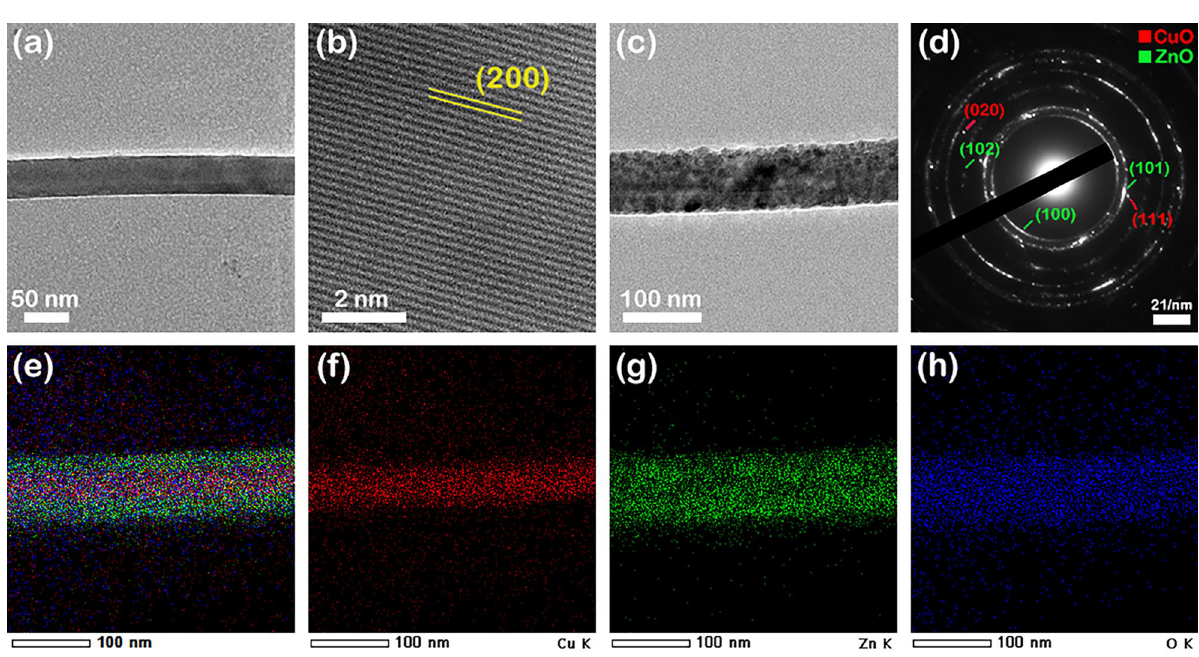
Figure 7. ( a ) TEM image and ( b ) HRTEM image of a single CuO nanowire (CuO_MIE sample), ( c ) TEM image and ( d ) SAED pattern of a single CuO–ZnO core–shell nanowire (CuO–ZnO_MIE_2 sample), ( e – h